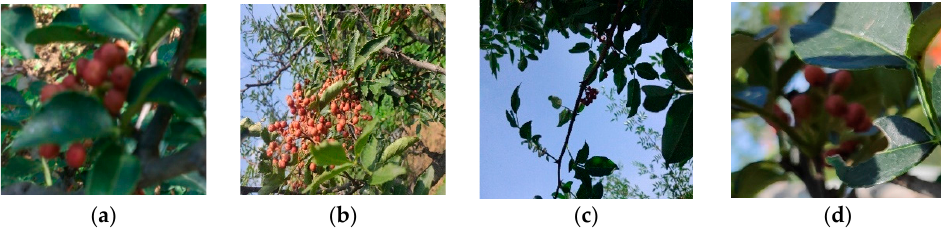
Figure 1. Images of Zanthoxylum peppercorn fruit under natural conditions. ( a ) Occlusion situation; ( b ) multi-mother plant overlap; ( c ) backlit conditions; ( d ) shading conditions.